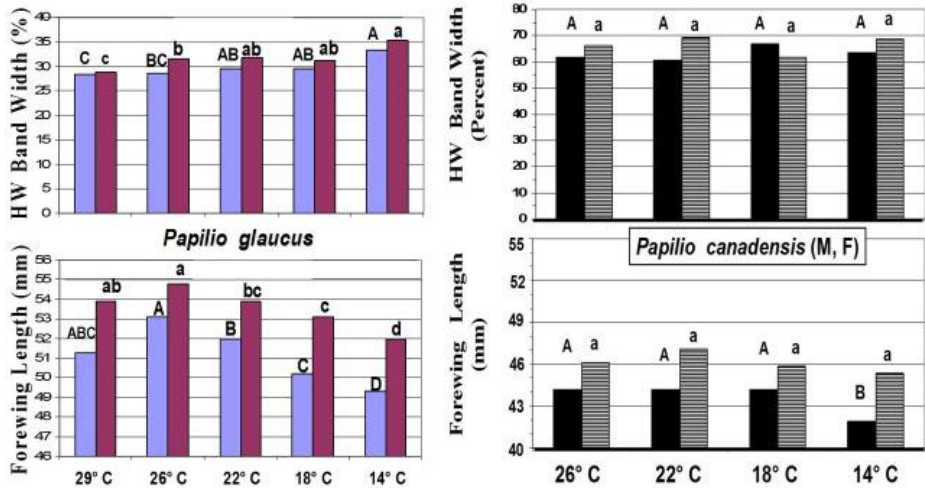
Figure 10. The forewing lengths and relative hindwing black band widths of the anal cell in; ( left ) P . glaucus ; and ( right ) P . canadensis as a function of Spring emergence temperatures (under 18:6 h photoperiod). Males are on the left (blue, solid black), females on the right (red, grey stripes). Significant differences between treatment means are indicated by different letters, by